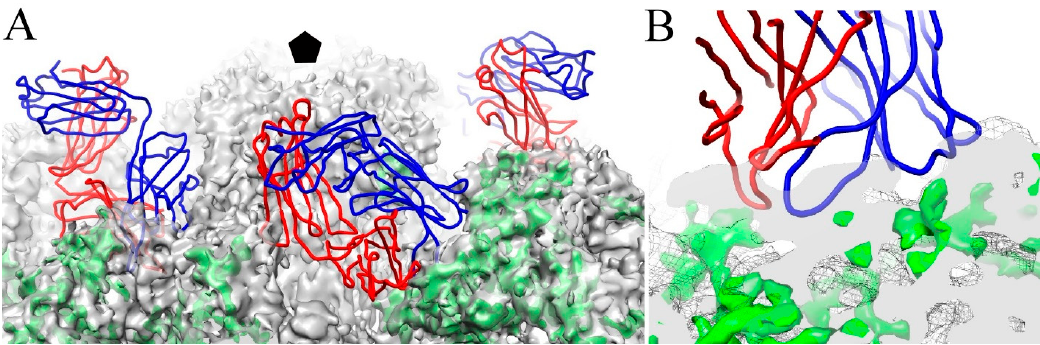
Figure 10. U4 may interact with the minor structural protein, L2. ( A ) The U4 Fab structure (heavy and light chain, blue and red, respectively) was superimposed onto putative L2 density identified previously (green) and the HPV16 capsid (grey mesh) (EMDB-6620) (37). The pentavalent capsomer is indicated in black pentagon. The zoomed view ( B ) shows the interface of the U4 variable domain with putative L2 density (green).